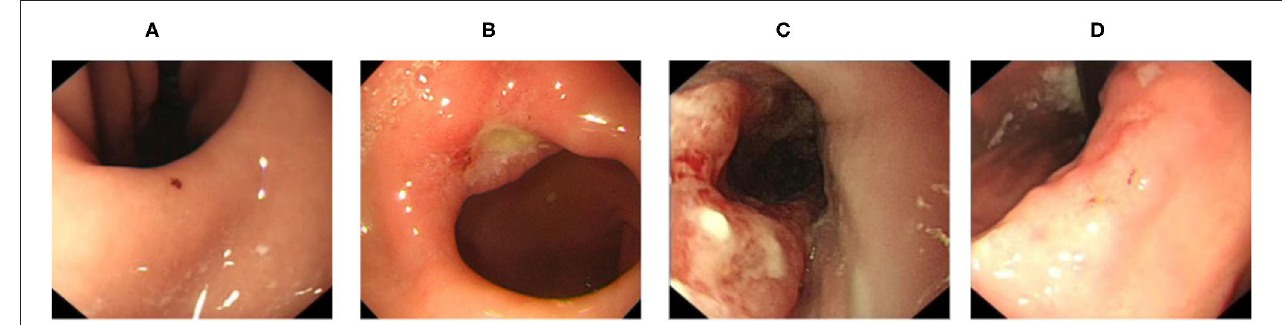
FIGURE 1 | Disease category: (A) erosive, (B) ulcer, (C) early caner, and (D) advanced